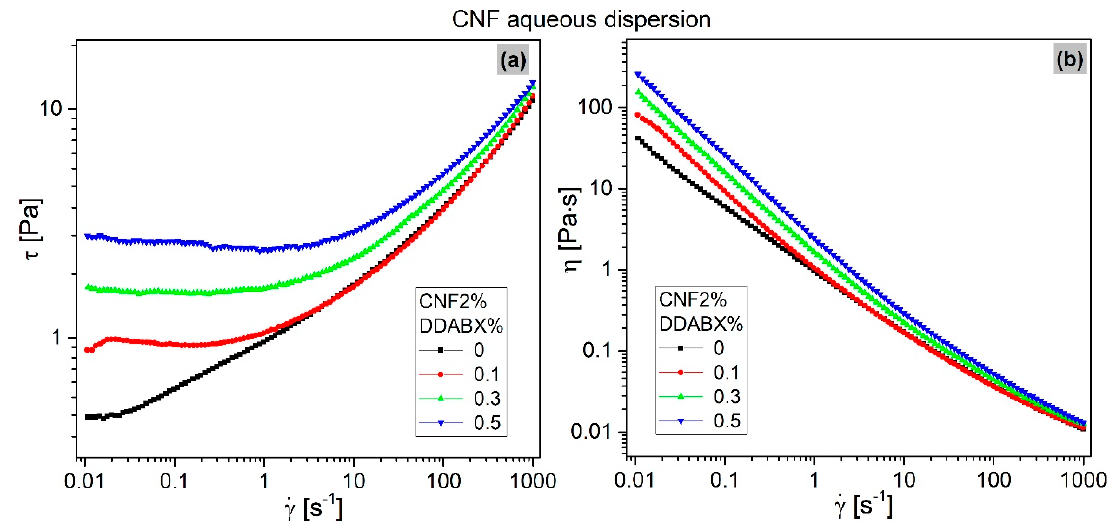
Figure 10. ( a ) Stress function and ( b ) viscosity function of CNF water dispersion with 2 wt.% CNF series.